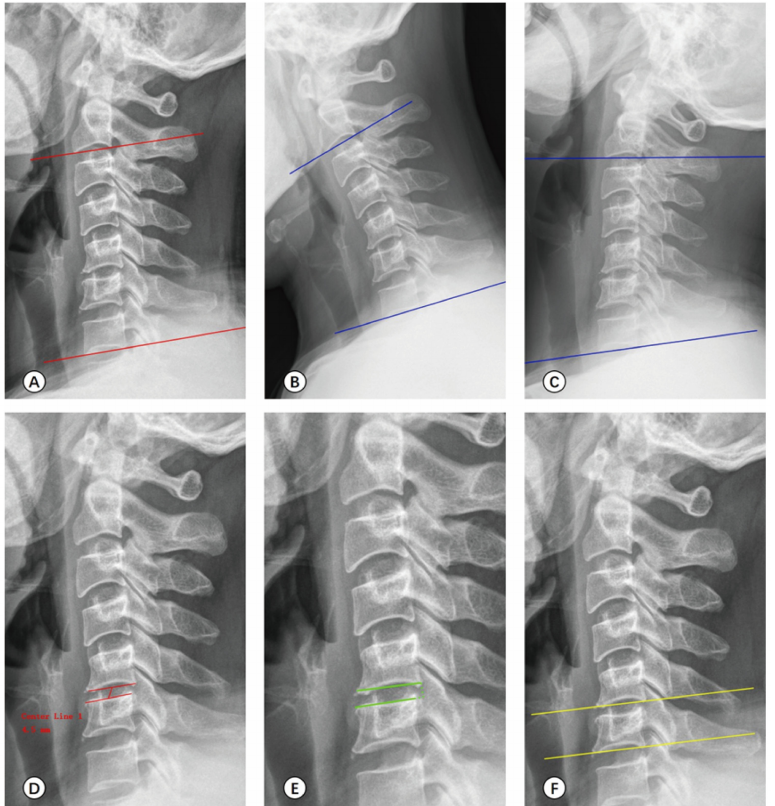
Figure 6. Schematic of imaging measurement. ( A ) C2-7 Cobb’s angle. ( B , C ) C2-7 ROM. ( D ) Interver- tebral height. ( E ) Vertebral horizontal displacement. ( F ) Vertebral angular